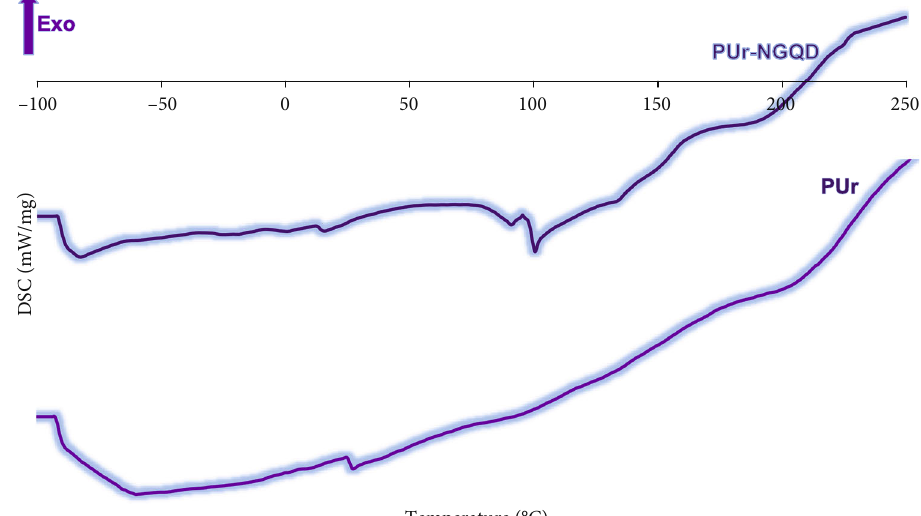
Figure 10: DSC Thermograms of PUr and PUr-NGQD